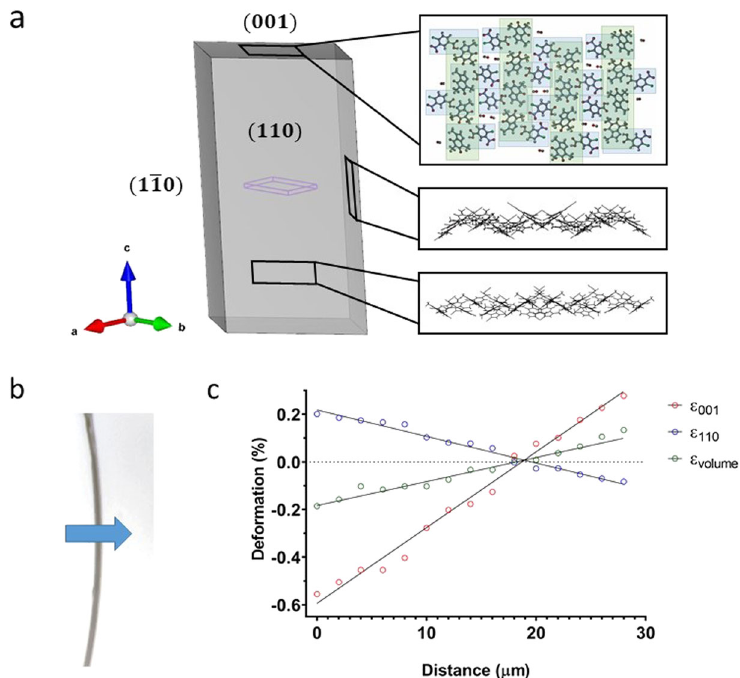
Fig. 1 The crystal structure of 1 and the deformation of a bent crystal. a Crystal packing of 1 with respect to the face-indexed crystal. The interlocked comb- like structure on the (001) face is emphasised through the green (hydrogen bonding) and blue rectangles. The wireframe view of the (110) and ( (cid:1) 110) faces emphasises the molecules which have their mean planes perpendicular to the face. b A bent co-crystal of 1 with thickness of ~38 µ m mounted for analysis. The blue arrow indicates the area covered by the mapping experiment and the direction it was performed in. c Deformation graph of 1 . Note that ε (110) is equivalent to ε (1 (cid:1) 10) due to symmetry. The fi rst dataset containing re fl ections is de fi ned at 0 µ m. For each data set the crystal was rotated through a 30° wedge (15° either side of the centre). The beam was centred off the edges of the crystal, which is ~38 µ m thick, at the start and end of the experiment. The centre of the crystal is located